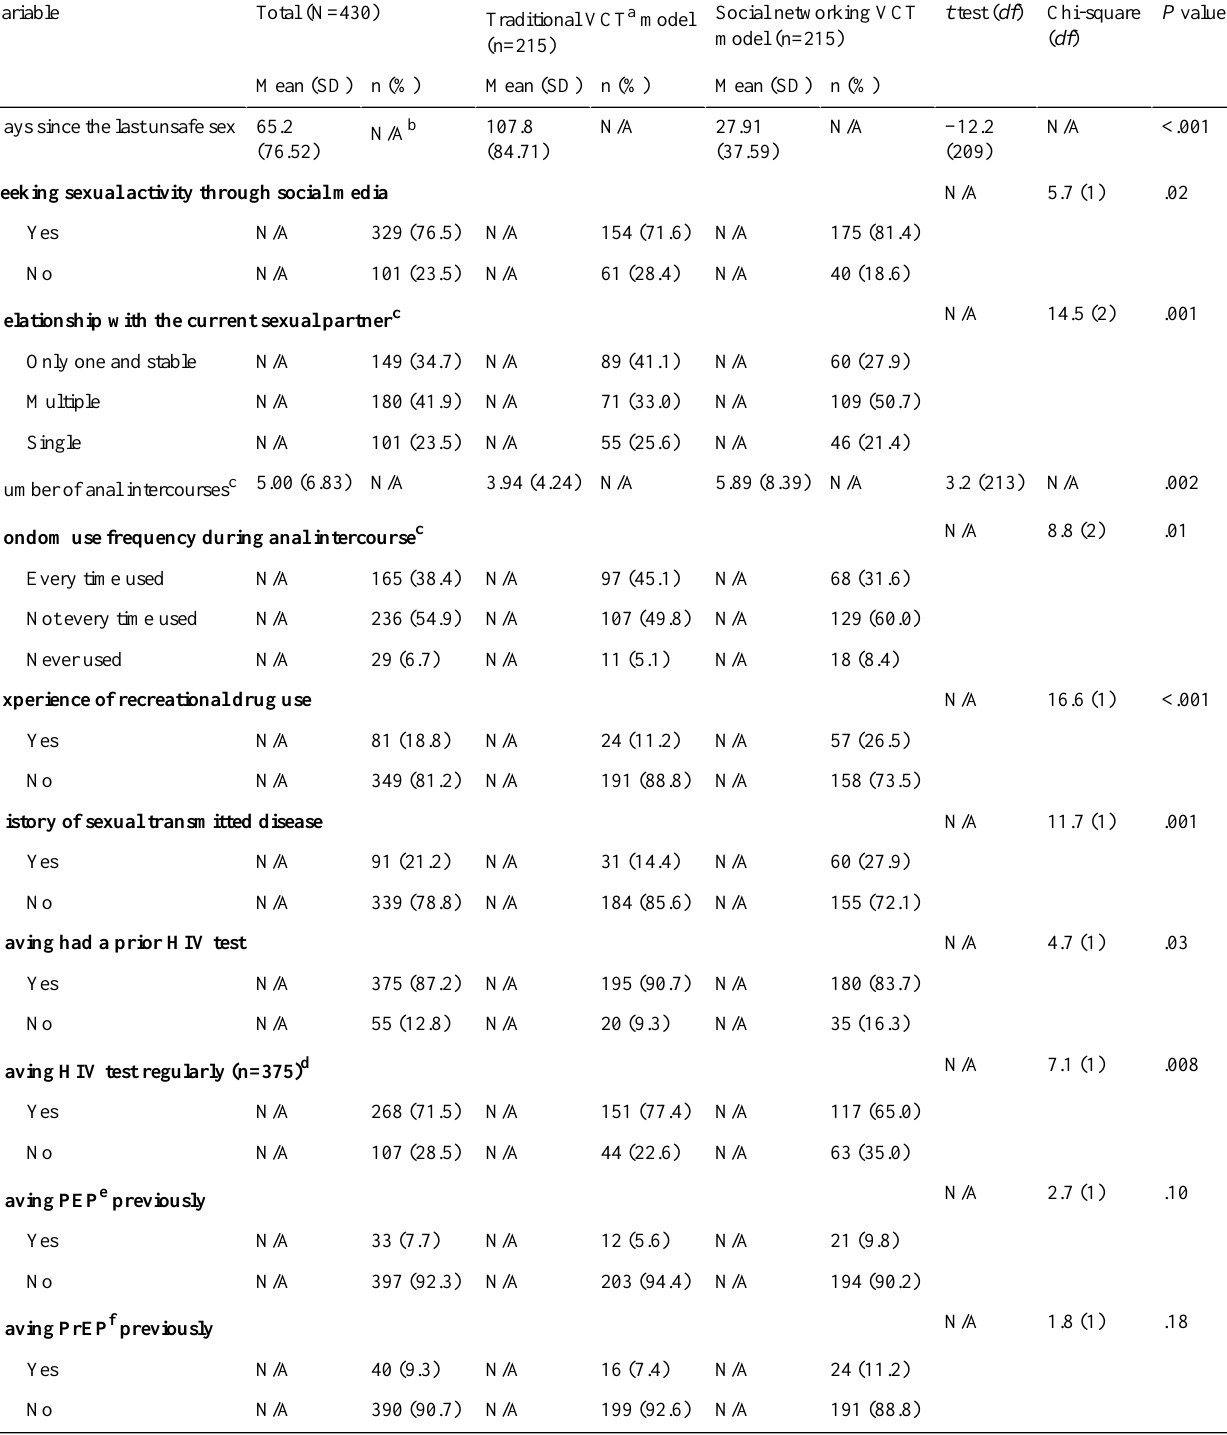
Table 3. The comparison of the risk-taking behavior of men who have sex with men between two voluntary counseling and testing models.